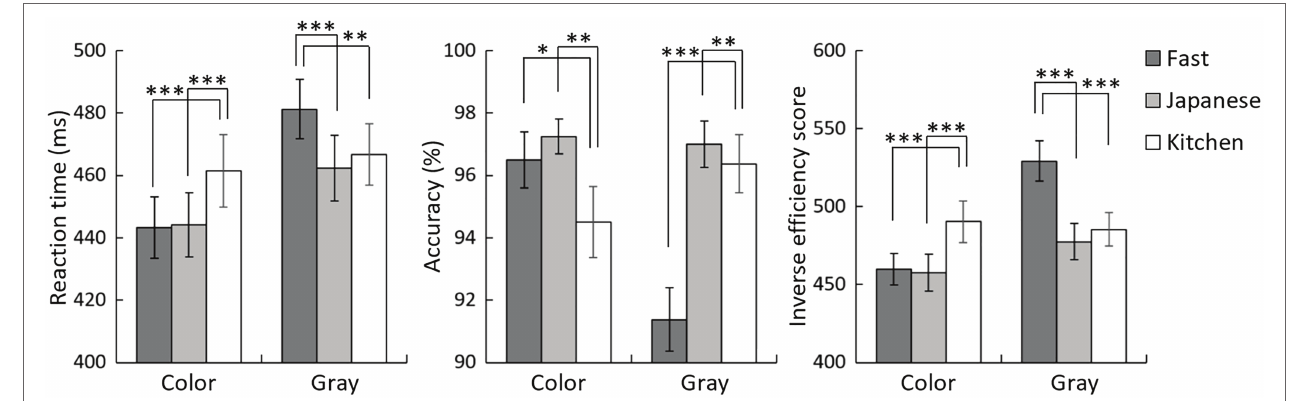
FIGURE 2 | Mean (with SE ) reaction times (left), percent accuracy (right), and inverse efficiency scores (right) for the detection of fast food, Japanese food, and kitchen utensils in the color and gray modes. Asterisks indicate significant simple effects of stimulus type. * p < 0.05; ** p < 0.01; *** p <